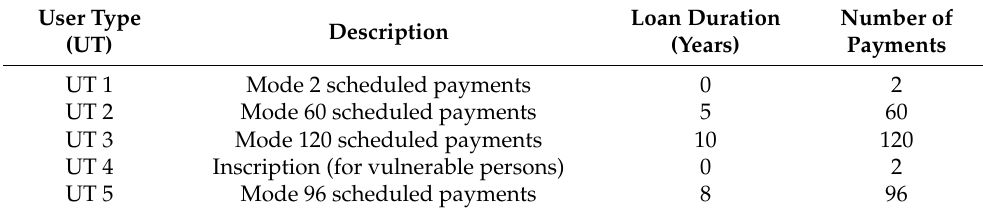
Table 4. List of user types (UT) adopted in the financial appraisal (Figure 8). Source: